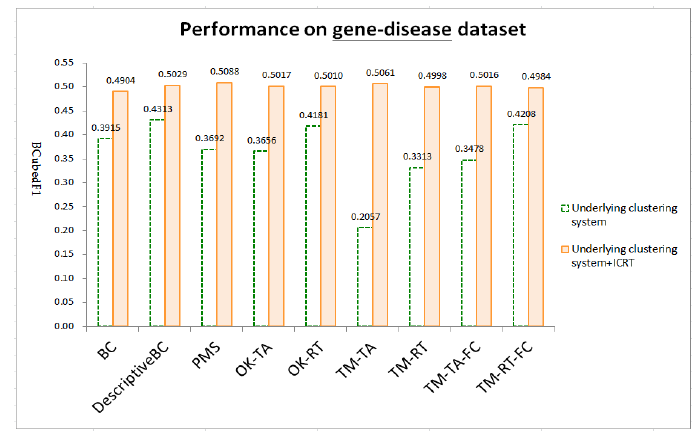
Figure 6. Test results on the gene-disease dataset.